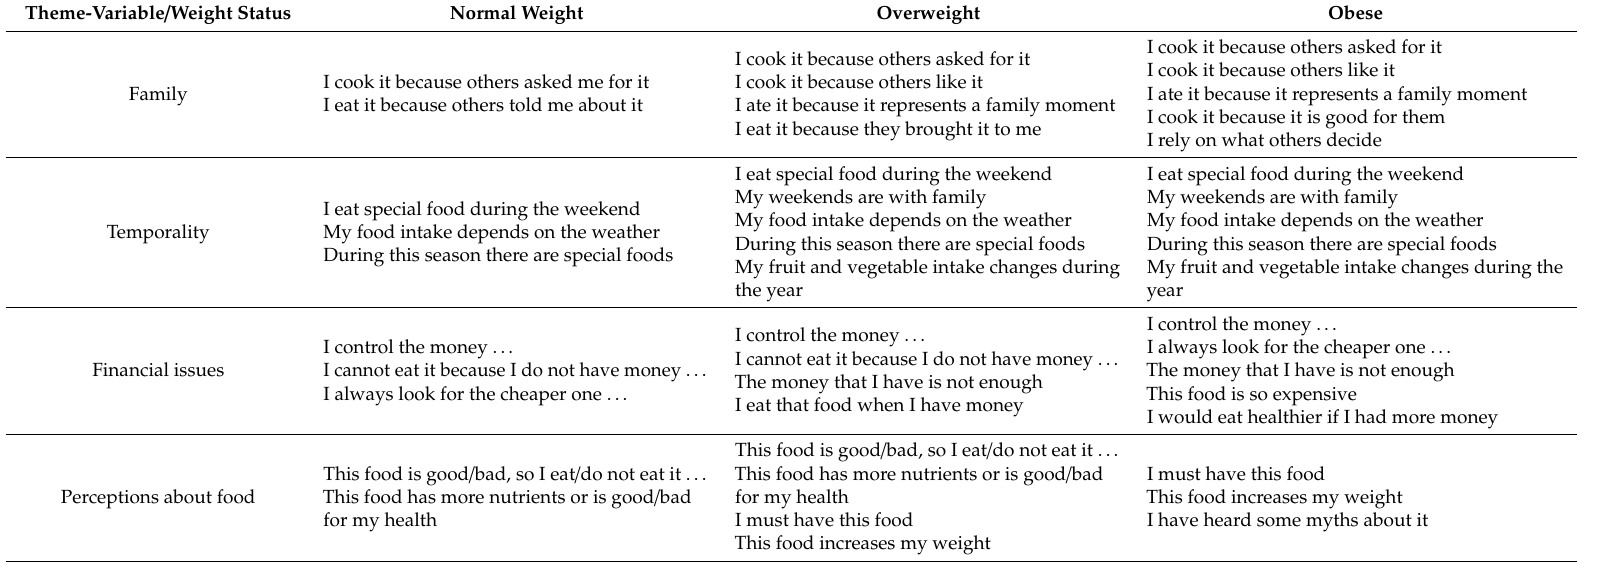
Table 2. Summary of the patterns within themes by weight status